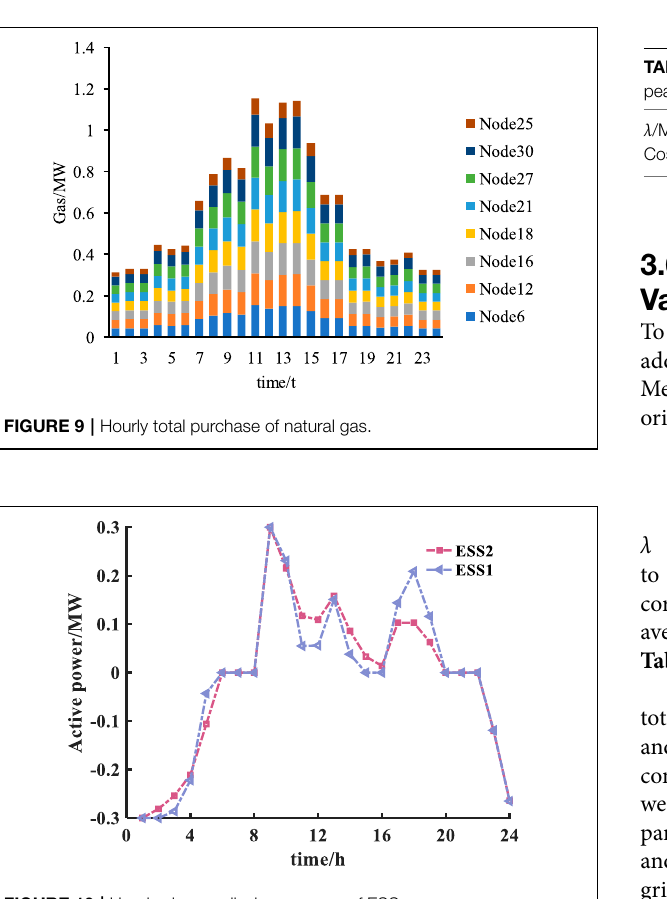
FIGURE 10 | Hourly charge–discharge curve of ESS.